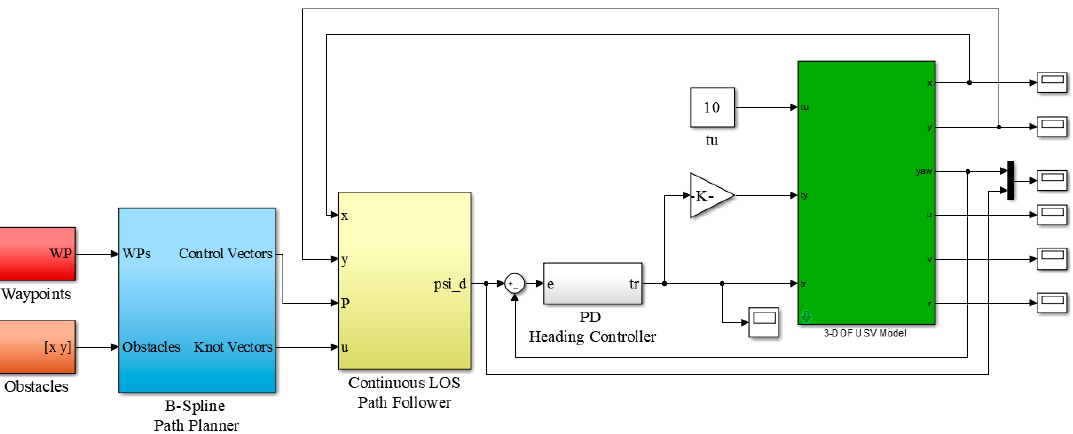
Figure 9. Simulink model of the overall system with B-Spline path planner and continuous LOS path follower.